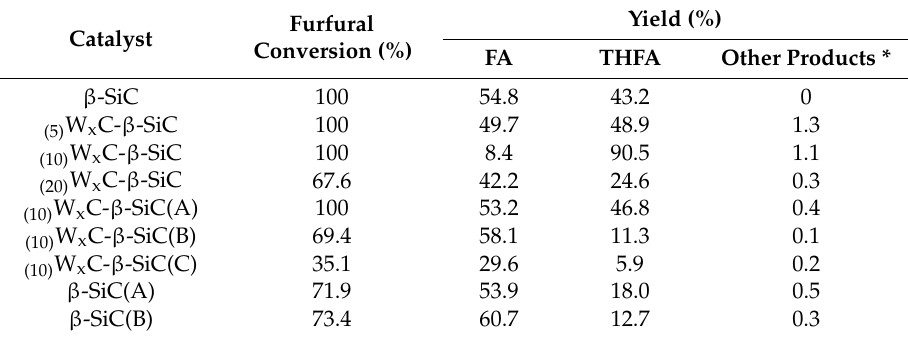
Table 1. Conversion of furfural and yields of FA and THFA after the 2 h hydrogenation of furfural over β -SiC and W x C- β -SiC catalysts. The results in the table are expressed as the arithmetic mean of a minimum of three measurements. Furfural Catalyst Conversion